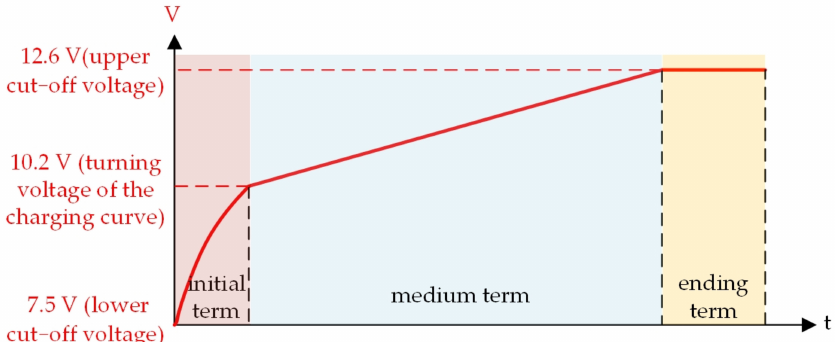
Figure 4. Schematic diagram of the proposed charging strategy.